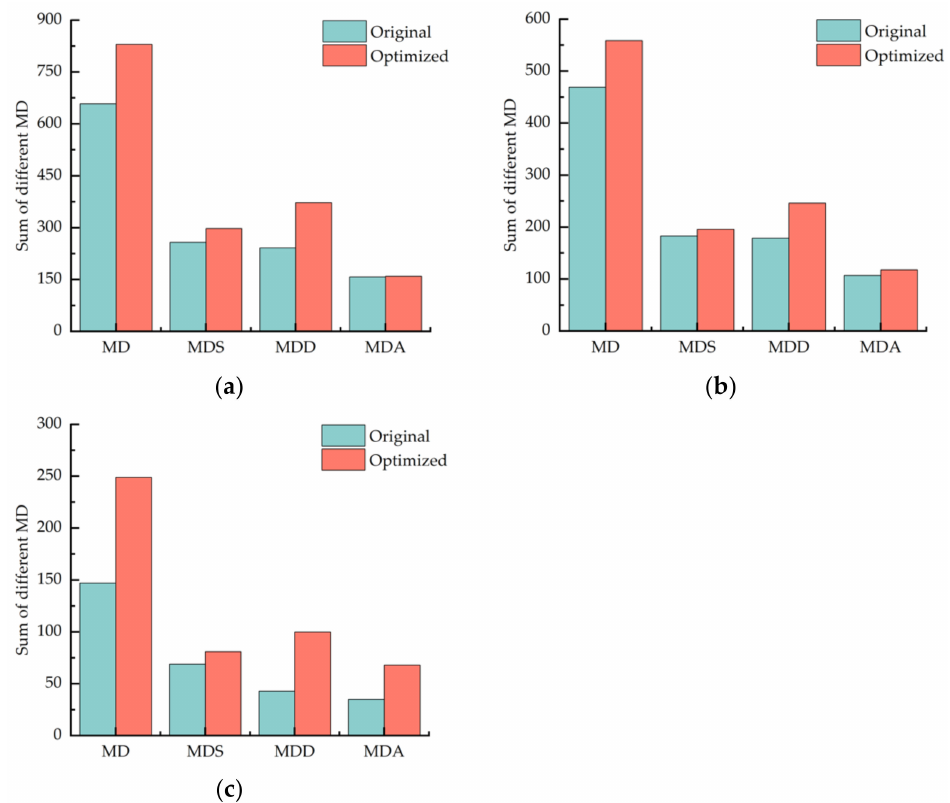
Figure 5. ( a ) Comparison of different MD before and after optimization under Peak scenario; ( b ) Com- parison of different MD before and after optimization under Normal scenario; ( c ) Comparison of different MD before and after optimization under Idle scenario.